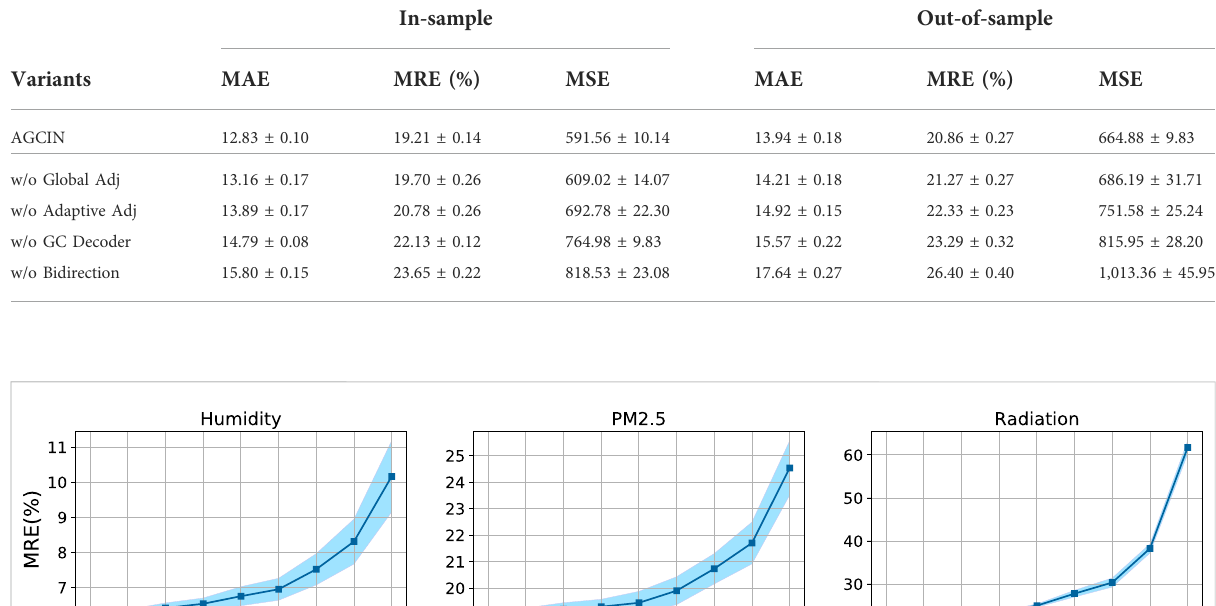
TABLE 3 Ablation study of the variants of proposed AGCIN by removing different designed modules.